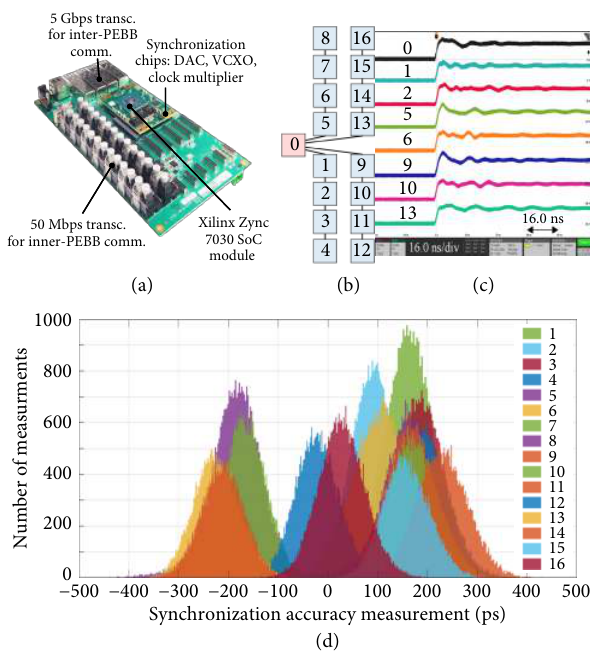
Fig. 9 (a) Controller prototype. (b) PESNet 3.0 inter-PEBB layer with 17 con-